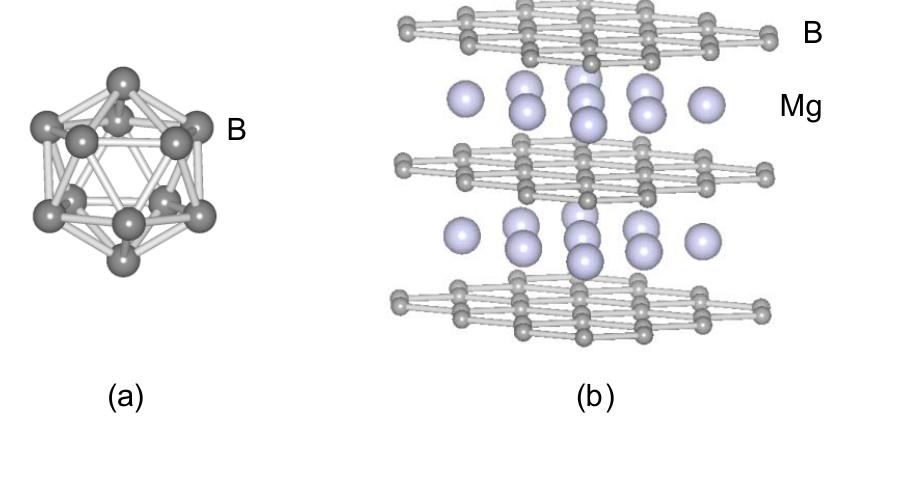
Figure 4. Schematic illustrations of (a) B